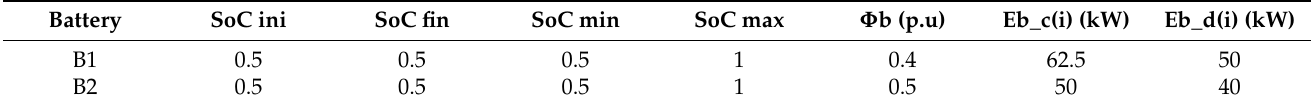
Figure 2. ( a ) Hourly demand curve, ( b ) RT market price, ( c ) wind turbine generation profile and ( d ) yearly PV generation profile aligned hourly. Table 1. Storage system characteristics of the test system. Taken from [32].